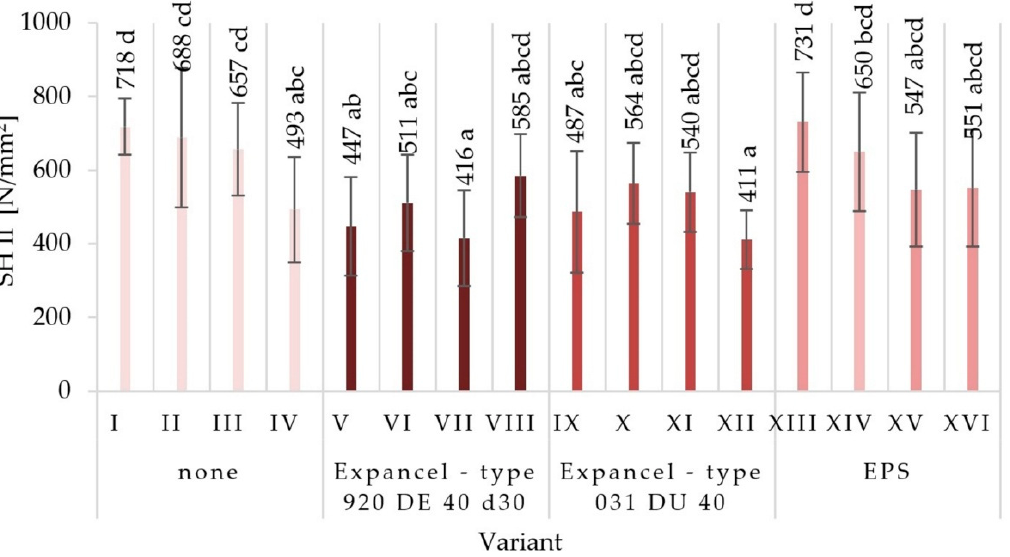
Figure 6. Screw-holding capacity parallel to the surface (SH II) of the particleboards produced (means and standard deviation, a, b, c, (…). Homogeneous groups were determined by the Tukey test; different letters denote a significant difference; means followed by the same letter do not statistically differ from each other).